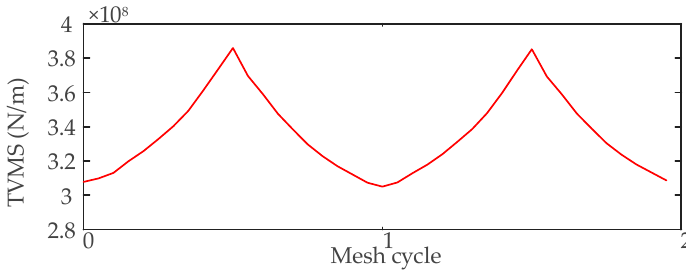
Figure 5. TVMS of the SBGP in a healthy state.